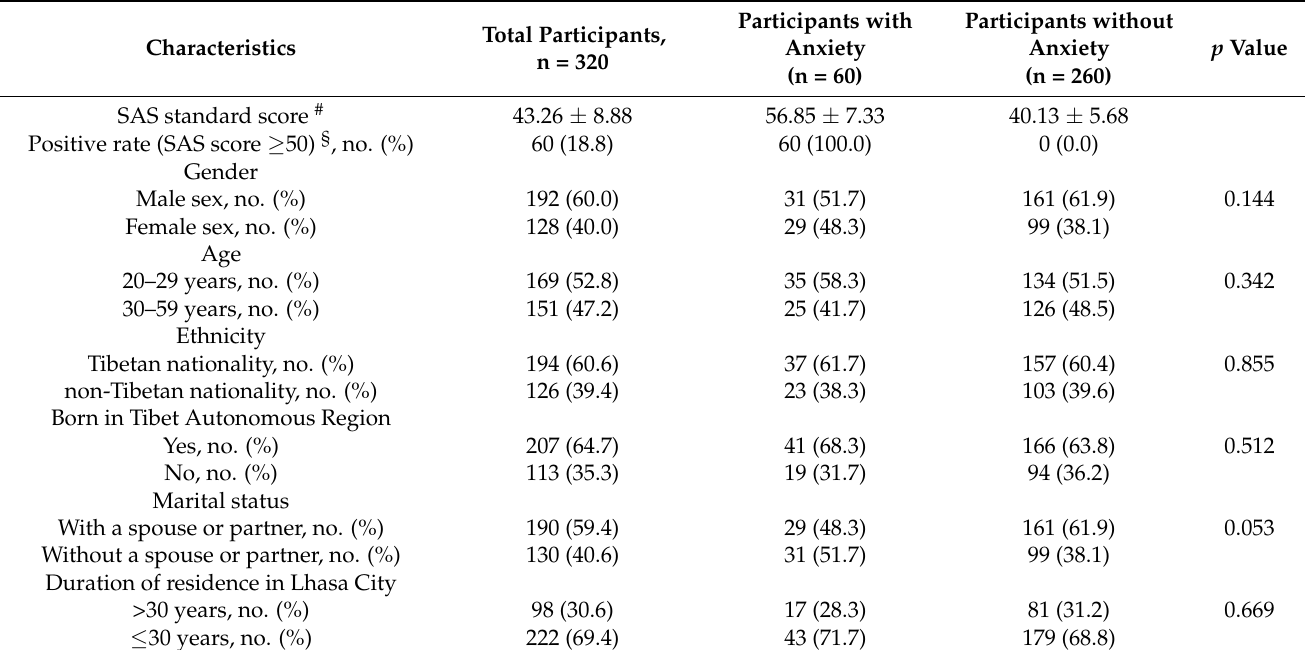
Table 2. Psychological fitness: the incidence of anxiety and a comparative analysis of 320 participants with and without anxiety.